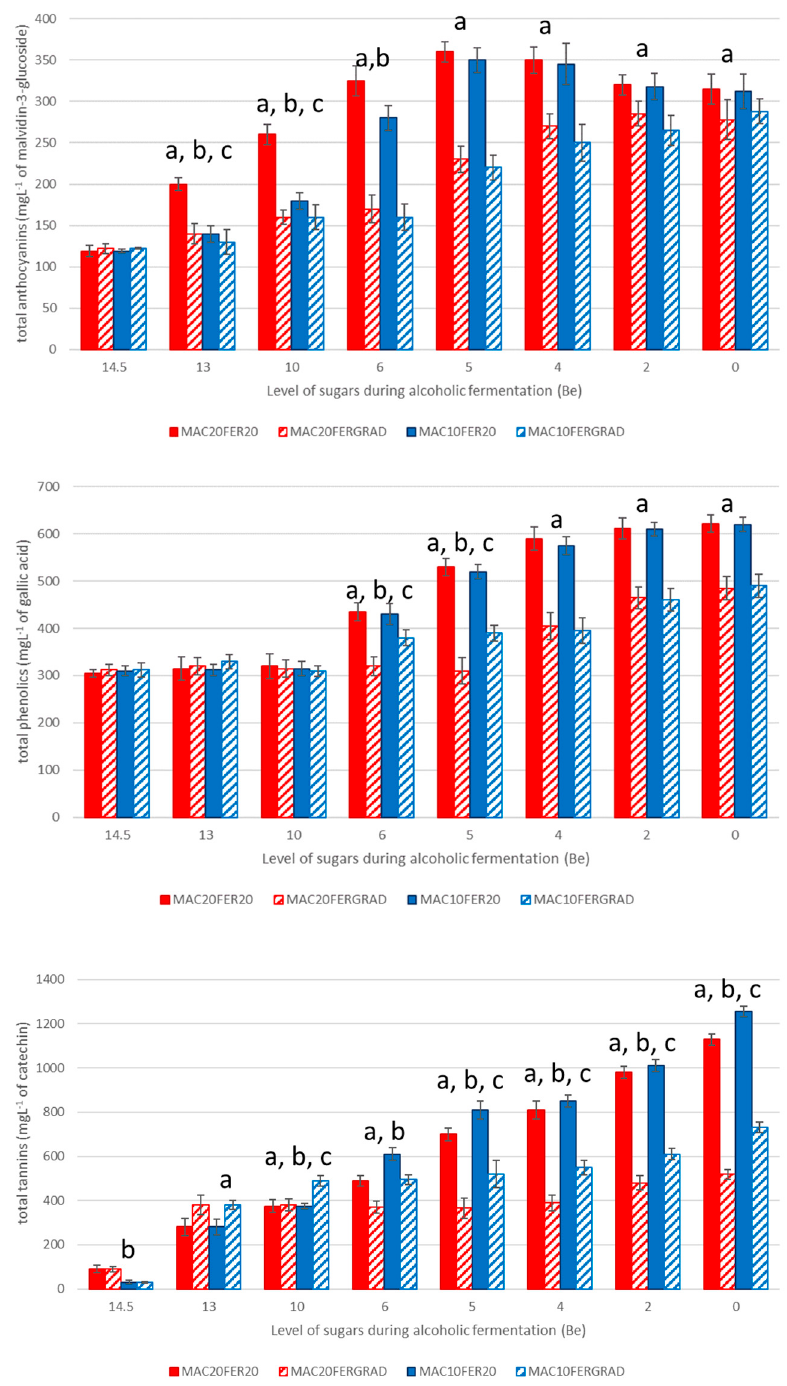
Figure 2. Evolution of the total content of anthocyanins (expressed as mg L − 1 of malvidin-3-gLucoside), phenolics (expressed as mg L − 1 of gallic acid) and tannins (expressed as mg L − 1 of catechin) over the fermentation processes under different conditions. a: significant differences due to changes in the fermentation temperature, b: significant differences due to changes in the maceration temperature, c: significant interactions between the maceration temperature and the fermentation temperature based on the ANOVA results ( p < 0.05).